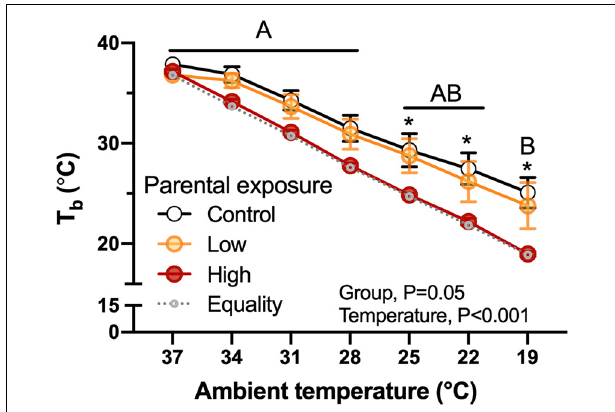
FIGURE 5 | Body temperature (T b ) as a function of declining ambient temperature in 7–8 day old king quail hatchlings (F 1 ) derived from parents (P 0 ) exposed to Control conditions or Low or High oil exposure through diet. Line of equality representing the decrease in temperature by the cooling protocol is shown as a gray dotted line. Data are expressed as mean ± 1 standard error of the mean. Different letters indicate statistical differences between temperatures. “*” indicate statistically significant differences between groups at the specific temperature. n = 4–8 per data point.